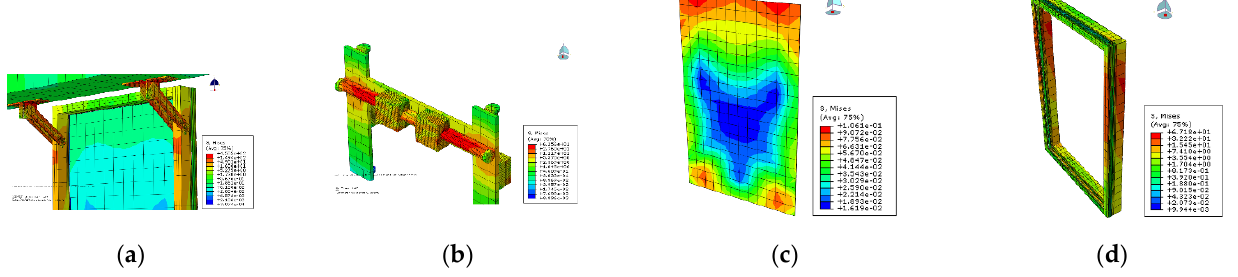
Figure 24. Stress distribution in each member of seismic curtain wall during Y -axis drift: ( a ) upper fastener-to-rigid beam connection part; ( b ) rail-to-moving clip connection part; ( c ) glass; ( d ) aluminum-to-PVC connection part.